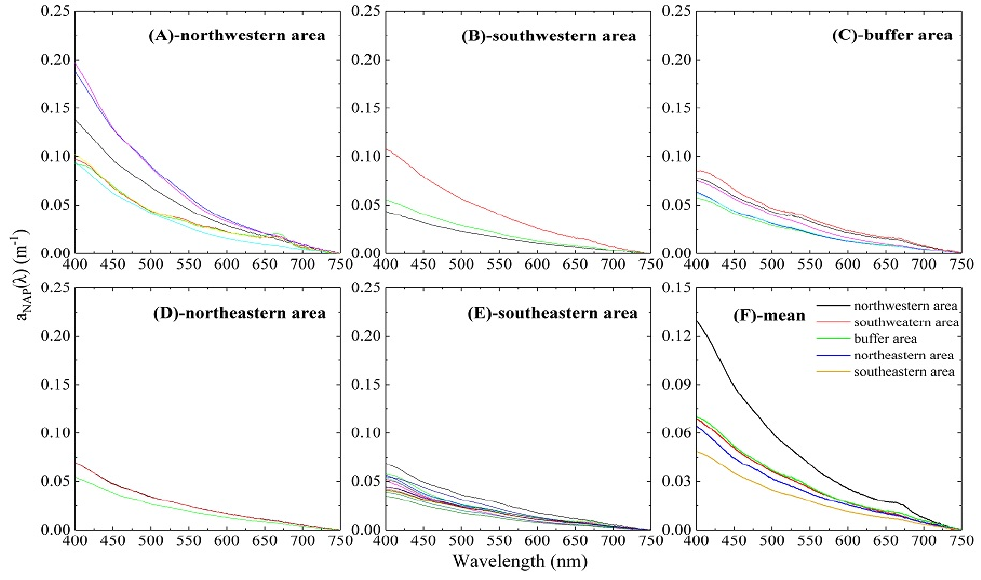
Figure 14. ( A – E ) NAP absorption spectra in different regions of the summer season in Lake Qiandaohu; and ( F ) the average NAP absorption spectra of each area.